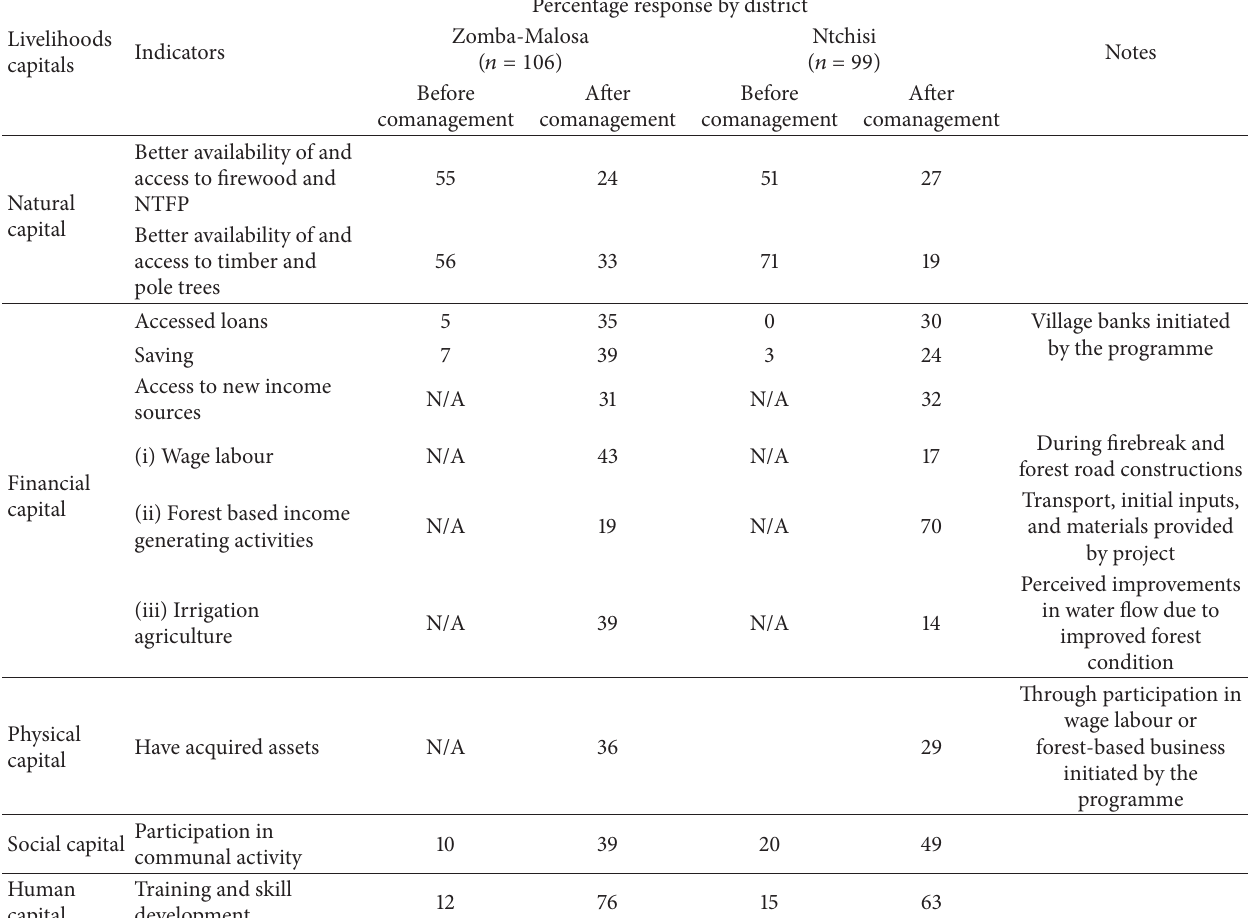
Table 3: Perceived livelihoods status before and after comanagement programme in Zomba-Malosa and Ntchisi.